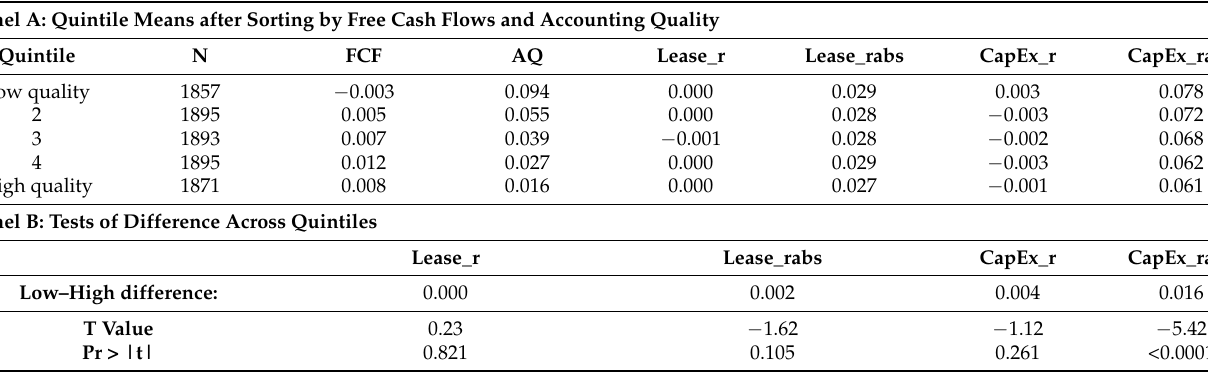
Table 5. Free Cash Flows, Accounting Quality and Unexpected Investments in Leases and